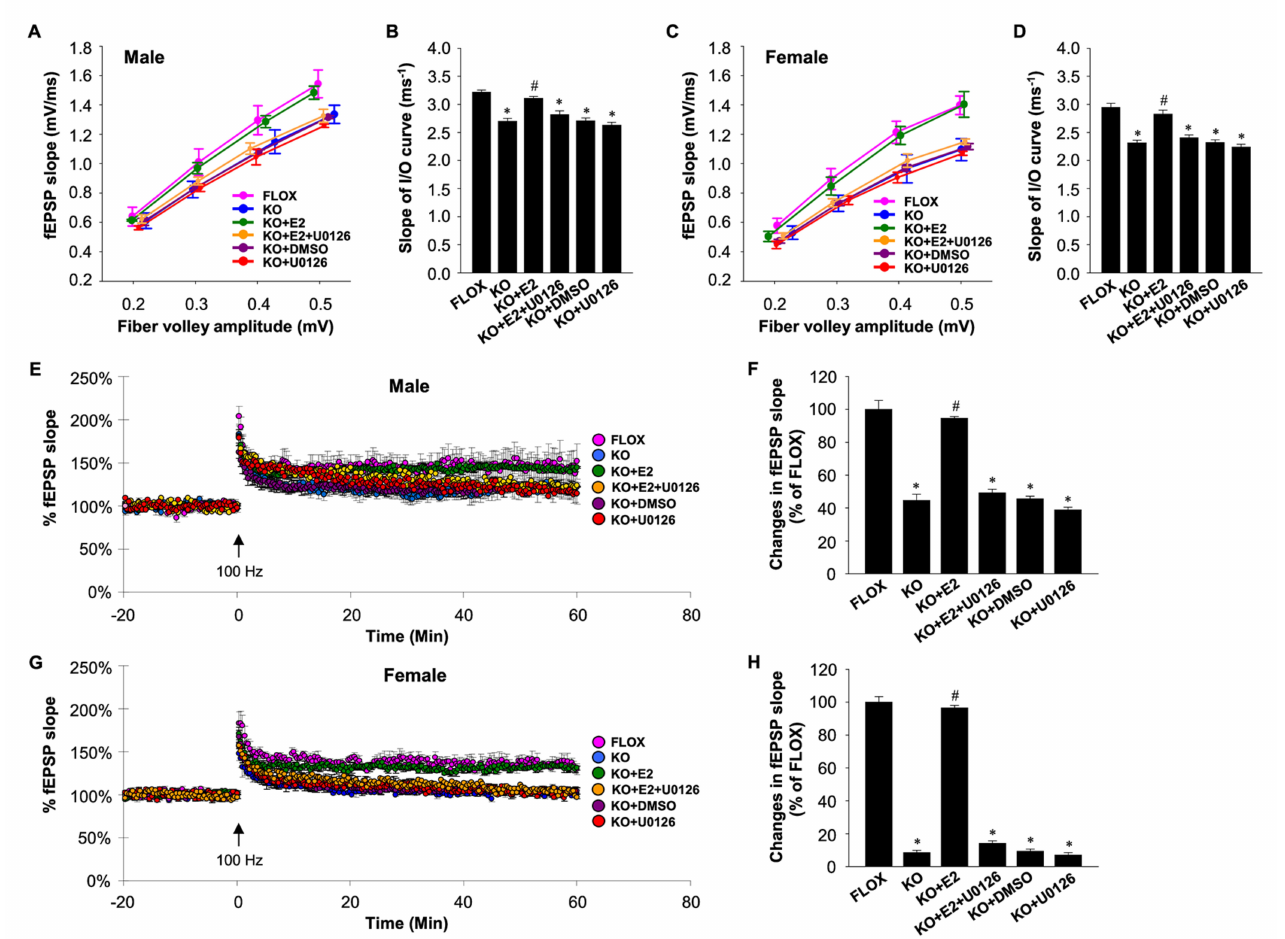
Figure 4. Functional synaptic plasticity is impaired in both male and ovariectomized female FBN-ARO-KO mice and rescued by acute 17 β -estradiol (E 2 ) treatment. ( A ) Examination of the alteration in excitatory synaptic transmission in male FBN-ARO-KO mice compared with the FLOX control, and the rescue effect by acute E 2 treatment (1 nM). In another group, U0126 (10 µ M), a MEK/ERK inhibitor was co-administered with E 2 to determine the role of MEK-ERK signaling in the regulation of acute E 2 benefit on synaptic transmission. ( B ) Quantification of the slopes of I/O curve obtained from linear regression of the I/O curves in A. ( C , D ) Analysis of excitatory synaptic transmission in ovariectomized female mice and the rescue effect by acute E 2 administration (1 nM) on FBN-ARO-KO brain slices. ( C ) In another group, U0126 (10 µ M) was co-administered with E 2 to determine the role of MEK-ERK signaling in E 2 rescue. ( D ) The corresponding changes in slope of I/O curve were quantified in. ( E ) Long-term potentiation (LTP) recording of Schaffer collateral synapses in above male groups by HFS (100 Hz, 1 s) stimulation, with the fEPSP slope measured for 60 min after LTP induction. ( F ) Quantitative analysis for changes in mean fEPSP slope between 50 and 60 min after LTP induction indicated in E. ( G ) LTP recording in ovariectomized female mice and ( H ) the analysis for fEPSP slope in each group. Values are means ± SEM of determinations from each group. N = 6 slices. * p < 0.05 vs. FLOX group, # p < 0.05 vs. KO group. Adapted from